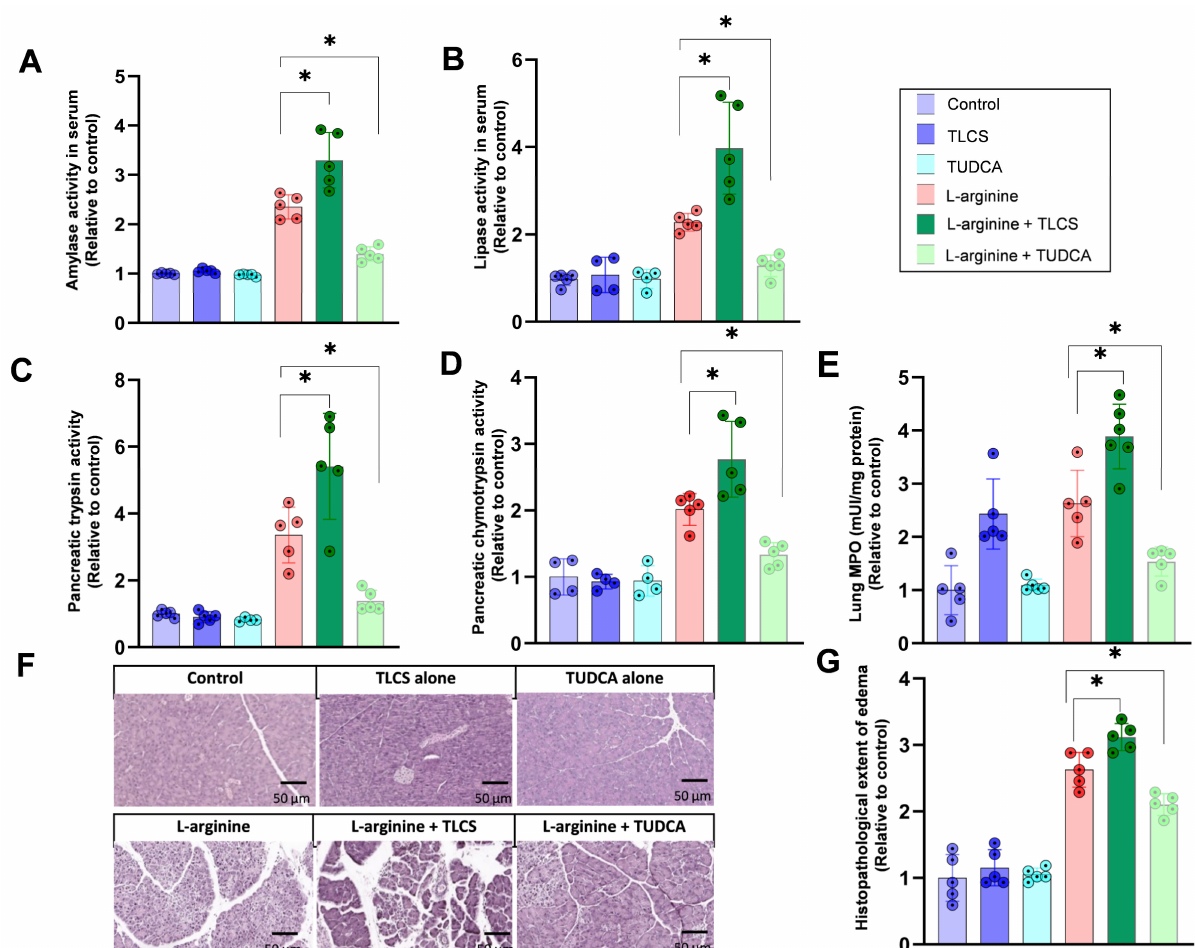
Figure 5. Effects of BAs in L-arginine-induced AP in mice. BAs were given via the same application route as for caerulein pancreatitis and mice were humanely killed after 72 h. ( A , B ) L-arginine induced AP, as shown by elevations of serum amylase and lipase after L-arginine injection. Pretreatment with TLCS caused disease aggravation, as shown by an increase in the enzyme activities, while TUDCA ameliorated disease severity. Neither TLCS nor TUDCA alone altered enzyme activities in the absence of L-arginine. ( C , D ) Pancreatic trypsin activity and chymotrypsin activity were enhanced in L-arginine pancreatitis. Protease activity was enhanced by TLCS pre-treatment and reduced